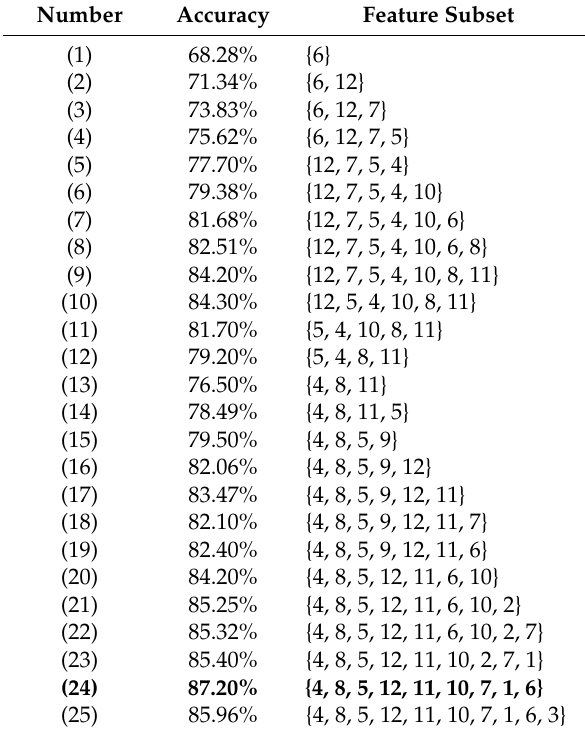
Table 4. Selection of color and textural